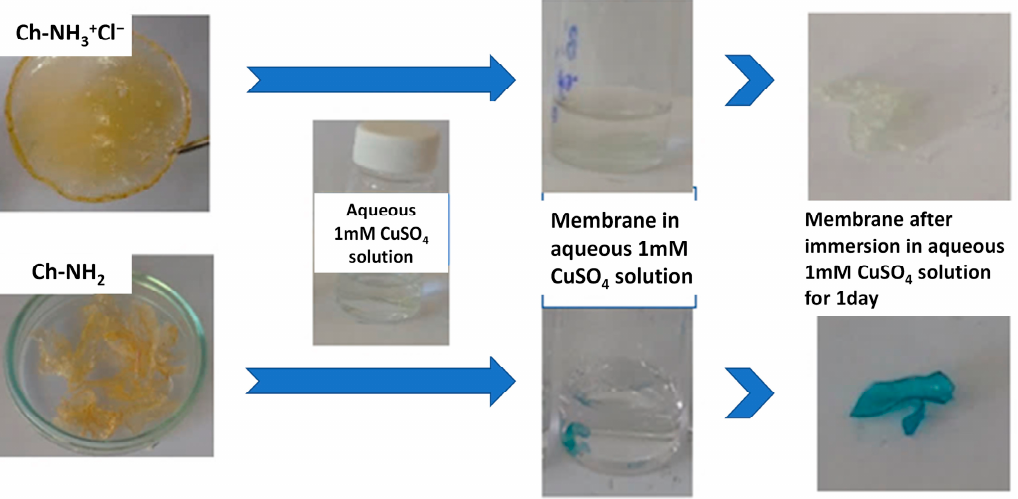
Figure 6. Representative images of the adsorption of copper ions by the membrane (Ch-NH 2 /P(DMAM- co-GMA) 8:2) compared to the appearance of the protonated Ch-NH 3+ Cl − /P(DMAM-co-GMA) 8:2 membrane, after immersion in aqueous 1 mM CuSO 4 solution for 24 h .